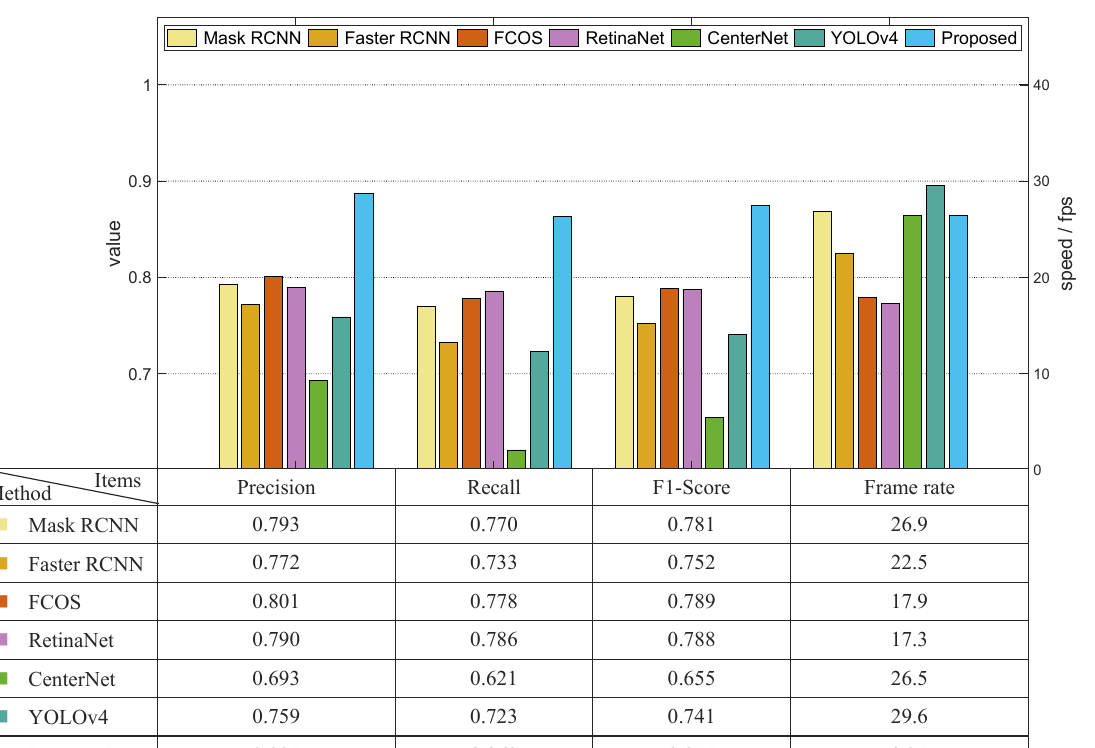
Figure 11. The results of ablation experiment for overall and shaded cases.